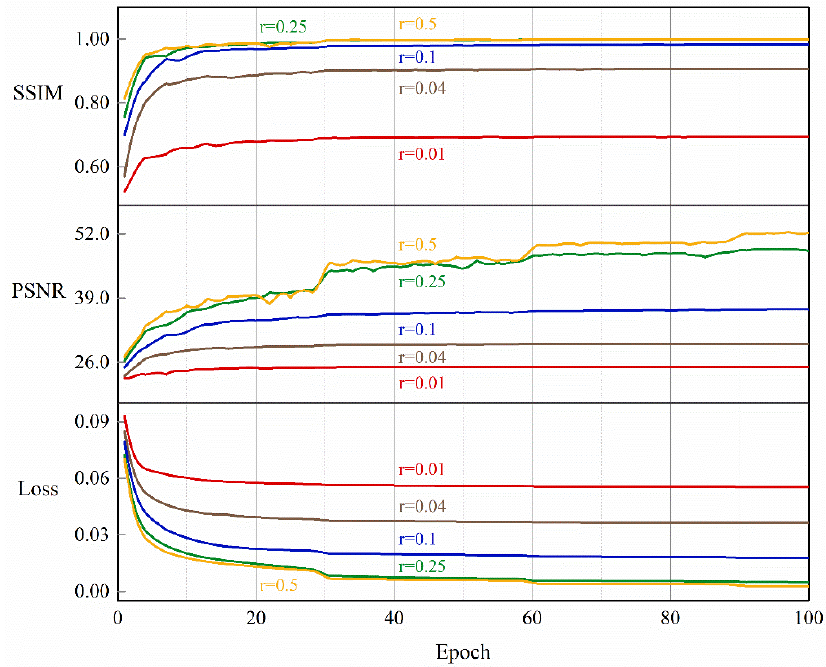
Figure 5. Training loss and validating PSNR and SSIM curves at different CS ratios.